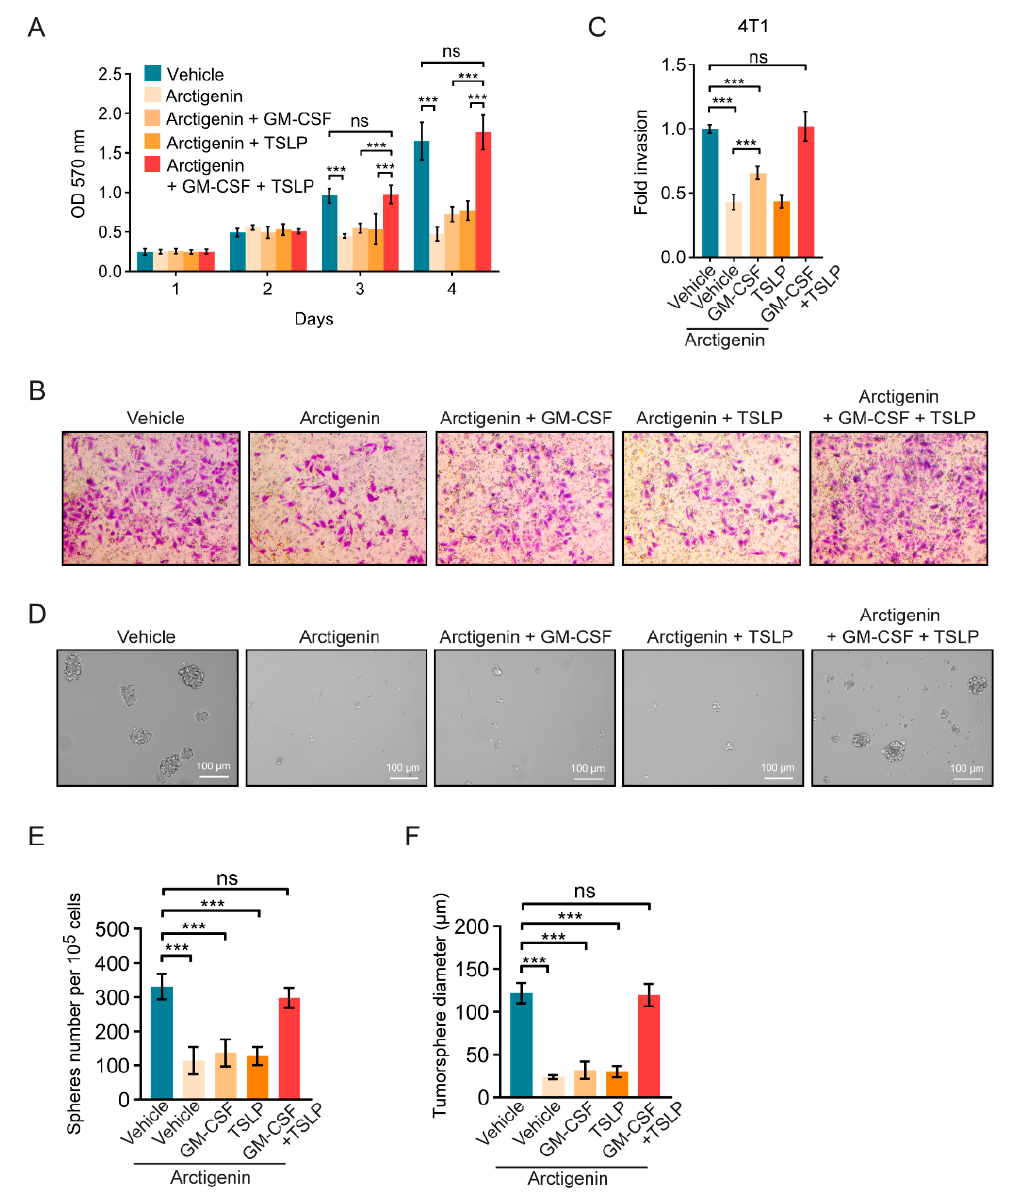
Figure 4. Arctigenin inhibits breast cancer cells proliferation, invasion and stemness through decreasing GM-CSF and TSLP. ( A ) Cell proliferation of 4T1 cells treated with arctigenin (20 µ M) in the presence or absence of GM-CSF (1 ng / mL) and / or TSLP (100 ng / mL). ( B , C ) Representative images ( B ) and statistics ( C ) of the invaded 4T1 cells treated with arctigenin (20 µ M) in the presence or absence of GM-CSF and TSLP. ( D ) Representative images of the tumorsphere formation of 4T1 cells in the presence or absence of GM-CSF and TSLP. ( E , F ) Quantification of tumorspheres formation e ffi ciency ( E ) and tumorsphere diameter ( F ). For ( A , C , E , F ), ns, not significant, p > 0.05, *** p < 0.001 (One-way ANOVA). Values represent mean ± SEM of three independent experiments.